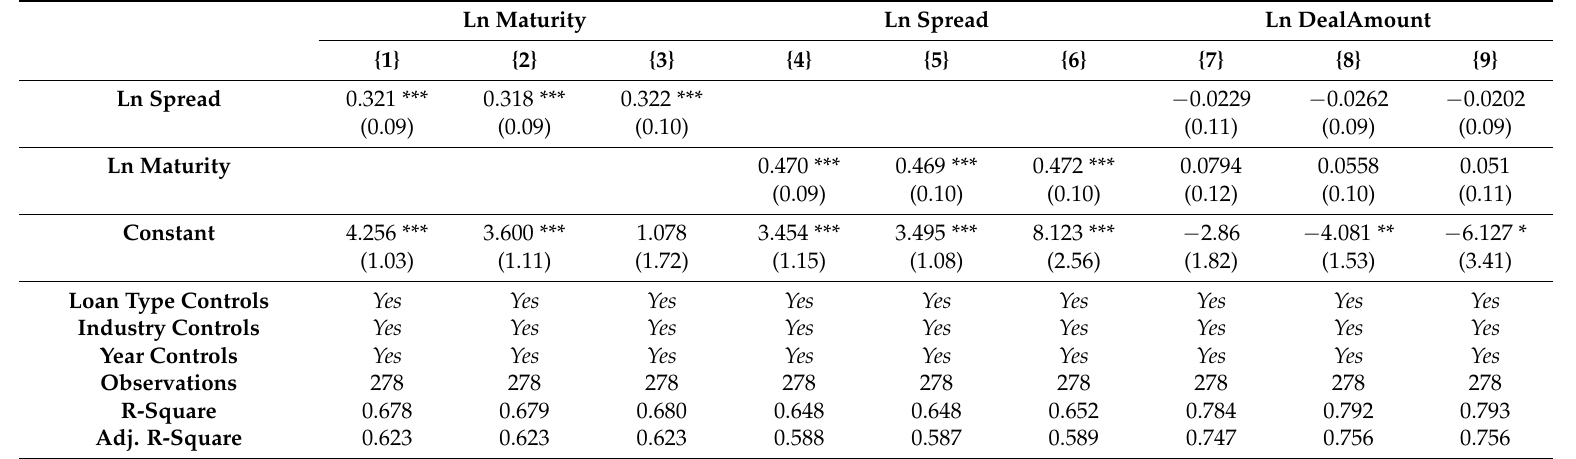
Table 8. OLS regressions of Cost of Loans on Group Affiliation Extent, Diversified, and Borrower and Loan Characteristics. Table 8 presents the pooled ordinary least squares (OLS) regression results of ln (Maturity), ln (Spread), and ln (DealAmount) on Group Affiliation Extent, Diversified, interaction terms, and Borrower and